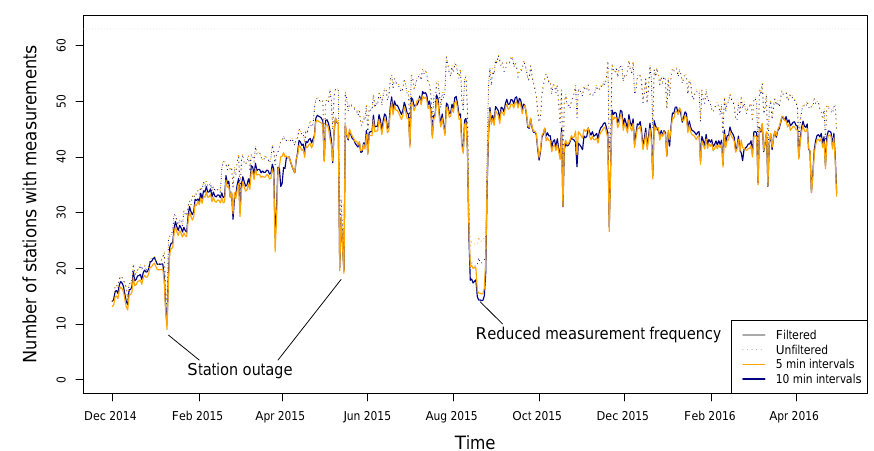
Figure 4. Number of stations with rainfall data from the PWS dataset, before and after applying filter, for every 5 and 10min interval over the entire period, smoothed per day. The two indicated dips correspond to complete outage of stations, the third with a longer period of fewer measurements in all stations.